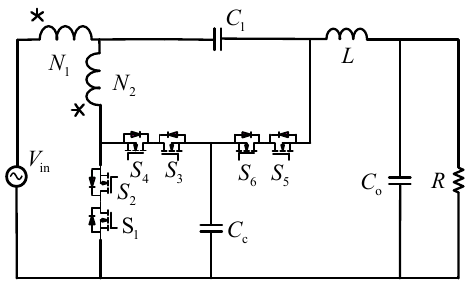
Figure 1 . Proposed reversal Γ -shape coupled inductor AC-AC converter. Figure 1. Proposed reversal Γ -shape coupled inductor AC-AC